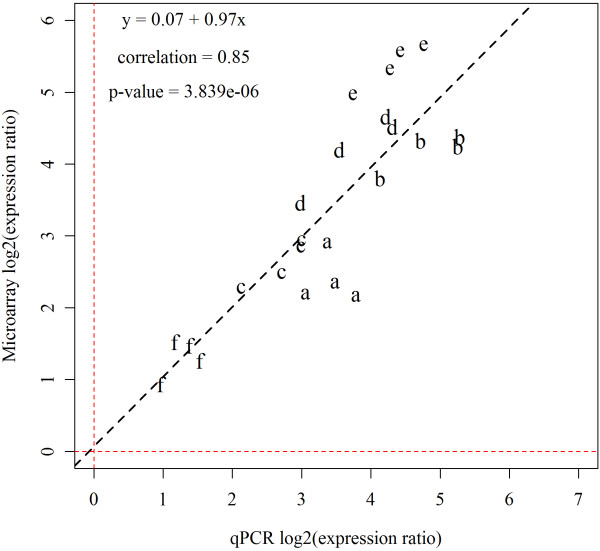
Confirmation of microarray results by qPCR. Expression levels of six genes were compared, as listed in Additional file 4. Log2-ER from microarrays was plotted on the y-axis, while log2-transformed fold changes from real-time qPCR were plotted on the x-axis. The four replicate pools of heart tissue from 4 wpi against control pools were measured for each gene. The dashed black line represents the regression function of the measured values. The function is shown in the top left corner of the plot. In addition, the Pearson correlation and the corresponding p-value are shown.